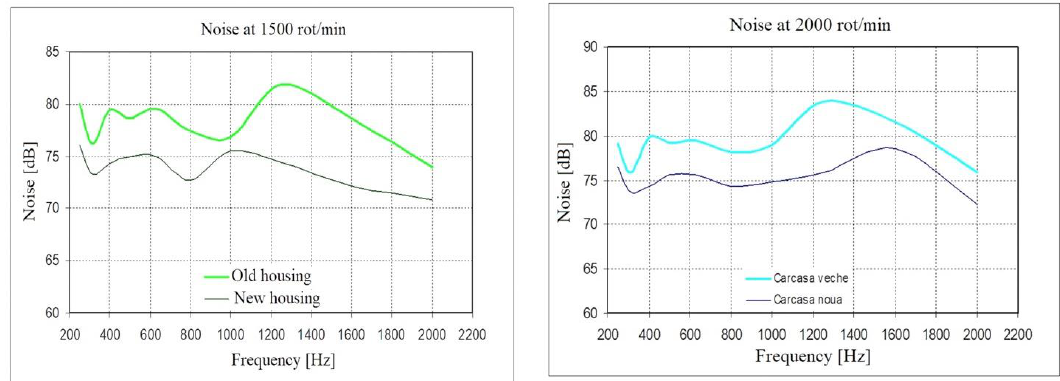
Figure 31. Lp sound pressure level diagrams for front surface at 1500 and 2000 rpm.